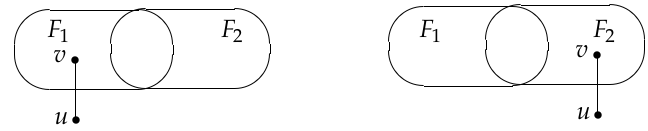
Figure 2. Illustration of a distinguishable pair ( F 1 , F 2 ) under Preparata, Metze, and Chien’s Fig. 2. Illustration of a distinguishable pair ( F 1 , F 2 ) under the PMC model (PMC)